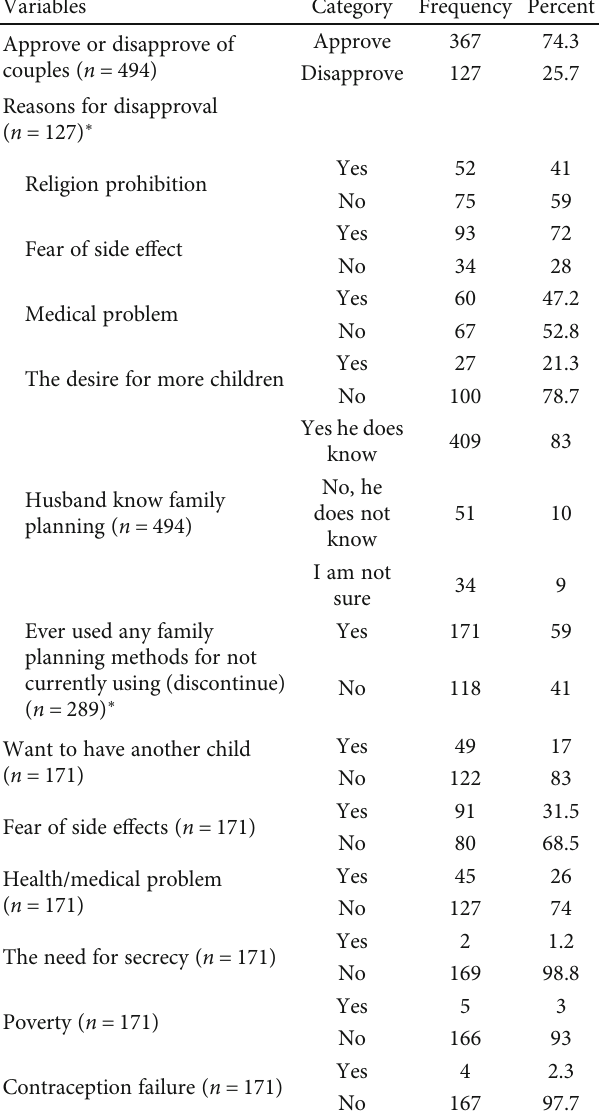
Table 3: Family planning factors among currently married reproductive age women in Toke Kutaye District, West Shoa Zone, Oromia, Ethiopia, March 2019; (supplementary